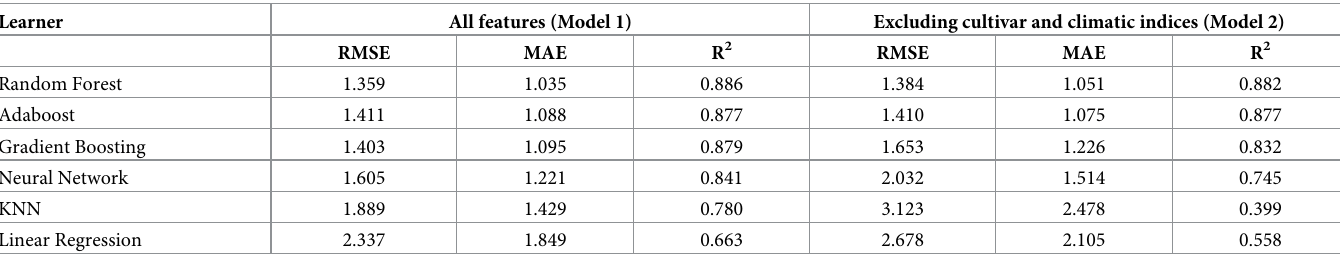
Table 2. Accuracy of machine learning models across features or after excluding the cultivar and climatic indices (RMSE and MAE expressed as ton ha -1 ). Learner All features (Model